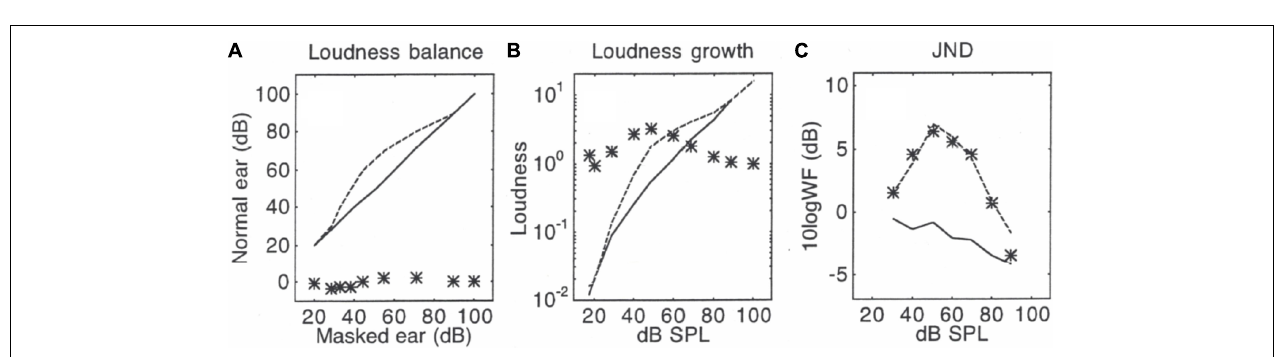
FIGURE 2 | Predictions in forward masking, with data (lines) from Zeng (1994). Panel (A) shows loudness balance functions between a tone in quiet ( y -axis) and a tone in forward masking ( x -axis): The solid line represents the control condition where the same tone was balanced between the two ears in quiet, while the dashed line represents the balance function for a tone in forward masking. The * symbols represent slope values for the balance function, which uses the same scale as the balance function from 0 to 100, except the slopes are unitless. Panel (B) shows derived loudness growth functions. The symbols represent loudness ratio values between the masked tone and the tone in quiet. Panel (C) shows the measured jnd functions (lines) and predicted jnd values (symbols).